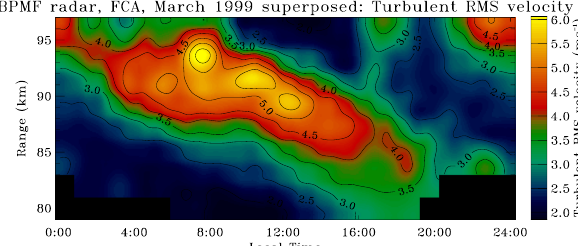
Fig. 6. Superposed epoch plot of the turbulent velocity for March